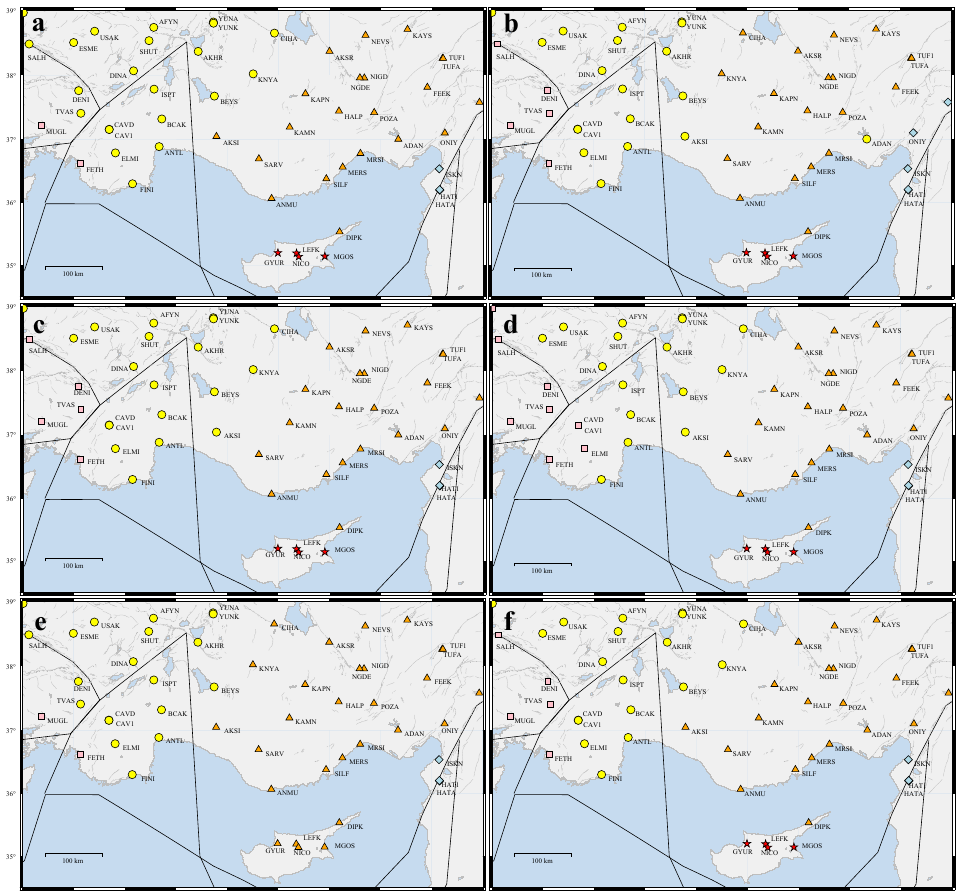
Figure 10. Comparison of individual clustering results with ensemble clustering for western Turkey with: ( a ) BIRCH; ( b ) HAC; ( c ) k -means; ( d ) mini batch k -means; ( e ) spectral clustering; ( f ) MCLA results. Black solid lines are the block model at [5]. Gray thin lines show active faults